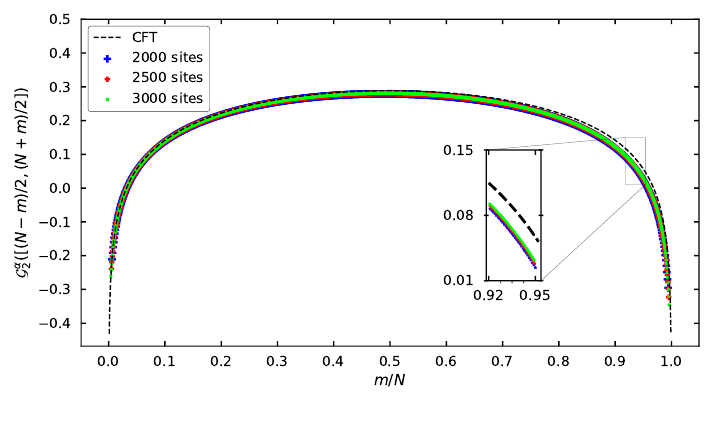
f ([ N − m ) / 2, ( N + m ) / 2 ]) for the Ising 2 G